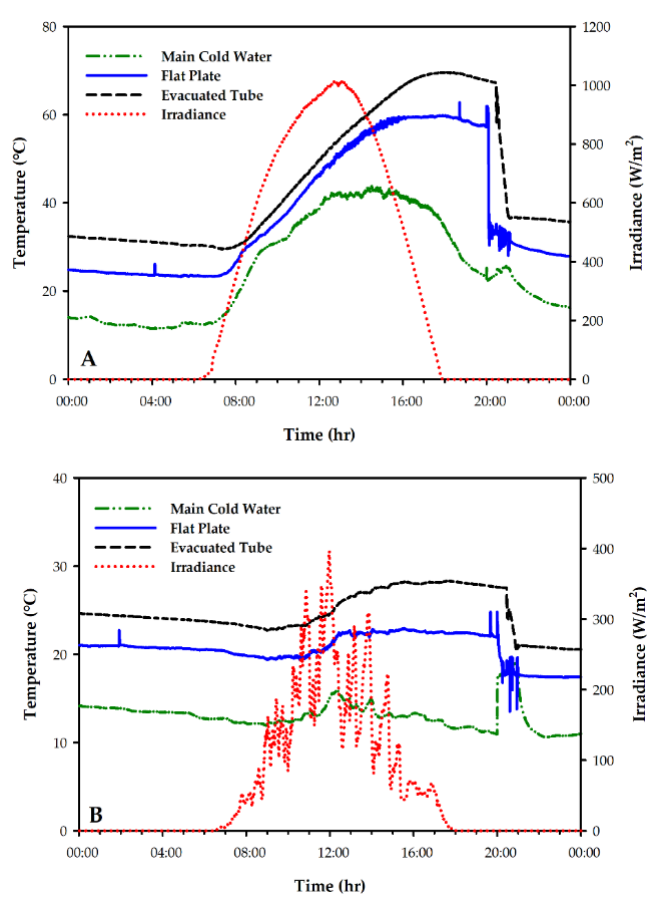
Figure 9. The performance of the flat plate and evacuated tube solar water heaters for a clear day ( A ) and cloudy day ( B ).